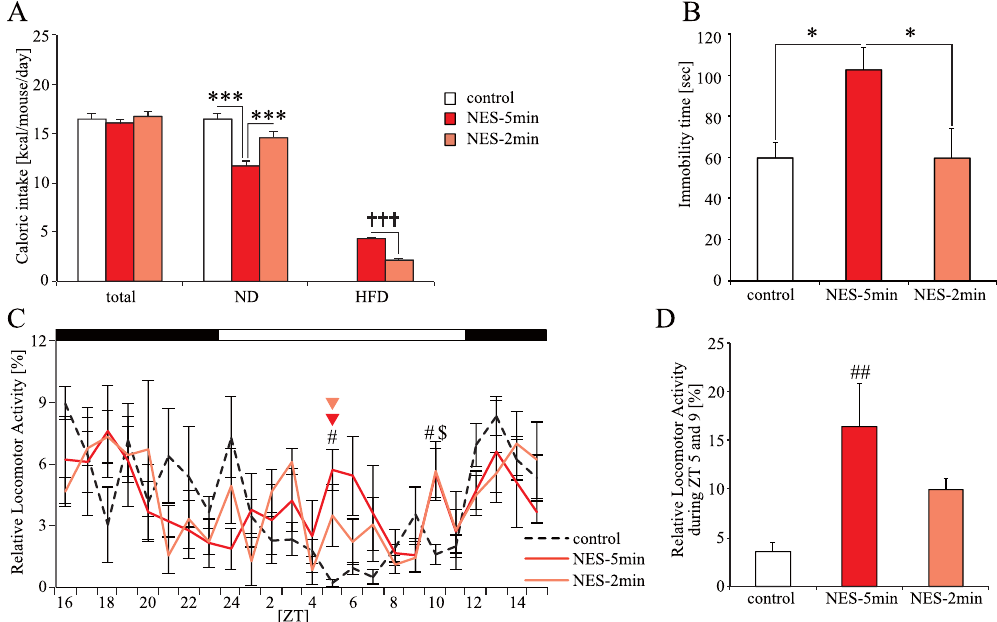
Figure 5. Effect of RF duration of 5-min and 2-min with HFD at ZT 5 on caloric intake, locomotor activity, and FST immobility time at ZT 1 (Experiment 5). ( A ) Average caloric intake of total, ND, and HFD under each feeding condition. ( B ) The FST immobility time at ZT 1. Data are presented as the mean ± SEM (control group, n = 6; NES-5 min and 2 min groups, n = 7). ( C ) Relative locomotor activity rhythm under each feeding condition. Red and orange triangles represent the commencement of RF. Open and closed bars indicate light and dark periods, respectively. ( D ) Sum of relative locomotor activity during ZT 5 and 9. Data are presented as the mean ± SEM (control group, n = 6; NES-5 min and 2 min groups, n = 4). * p < 0.05, *** p < 0.001 (one- way ANOVA with Tukey’s multiple comparison test); ††† p < 0.001 (Student’s t -test). # p < 0.05, ## p < 0.01 the NES-5 min vs. the control group; $ p < 0.05 the NES-2 min vs. the control group (Kruskal-Wallis test with Dunn’s multiple comparison